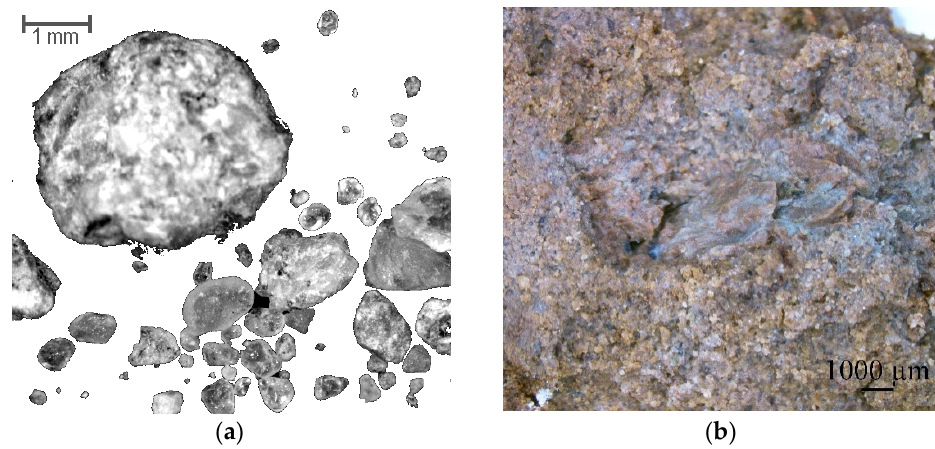
Figure 2. Tested soils in magnification; ( a ) Grains of Sand 3 in magnification (data from [39]); ( b ) Grains of the saclSi soil in magnification (the sample’s cross-section).